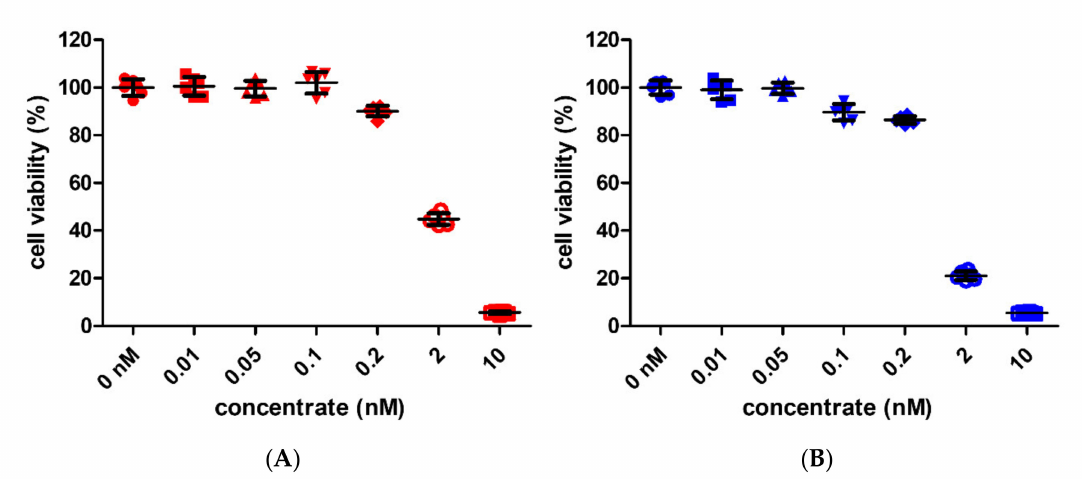
Figure 2. ( A , B ) Effect on the cell viability of bone-marrow-derived macrophages (BMMs). The BMMs were cultured with a culture medium (CM, without the RANKL medium) for two days. The concentrations of GNPs and SNPs were 0, 0.01, 0.05, 0.1, 0.2, 2, and 10 nM. The results are expressed as the mean ± standard deviation (SD, n = 6 per